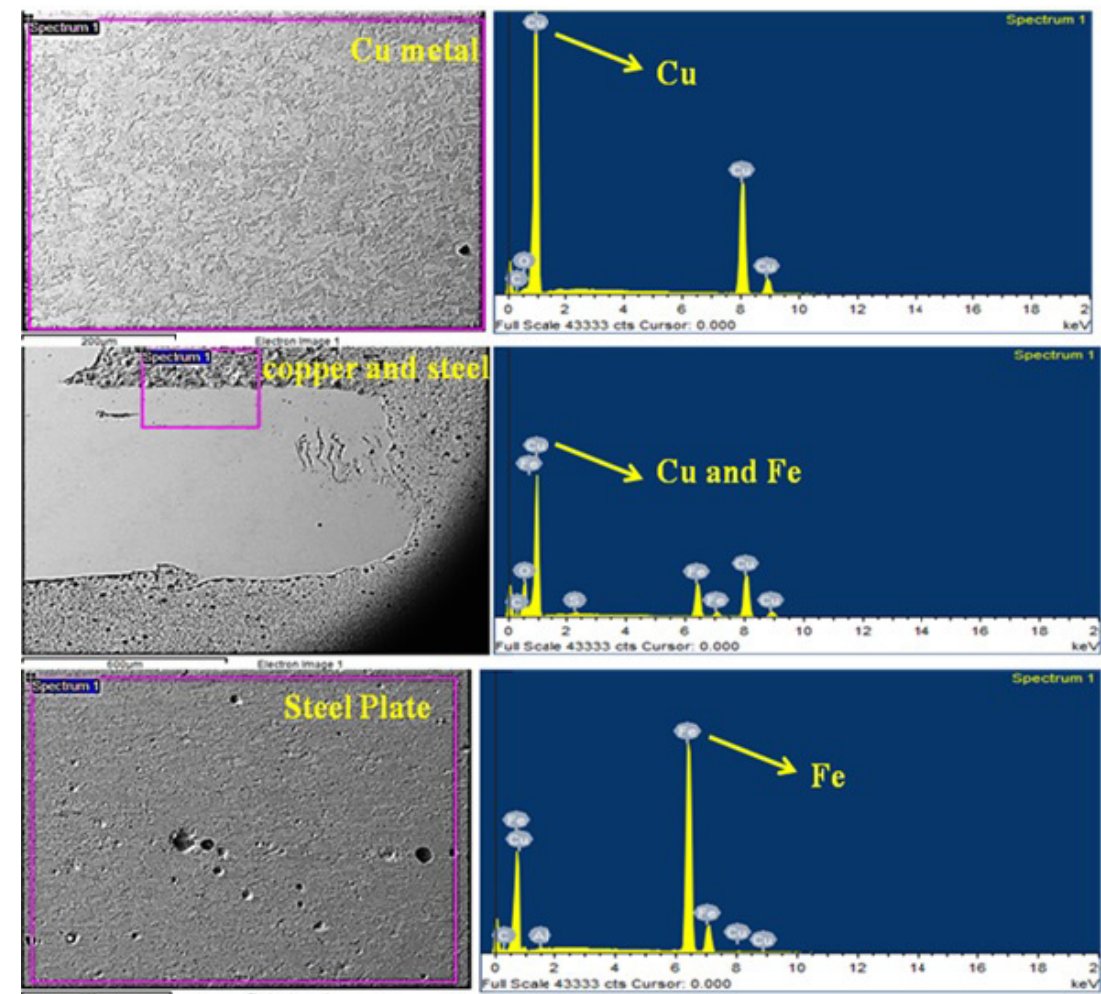
Figure 8. Elemental analysis of copper and steel at the